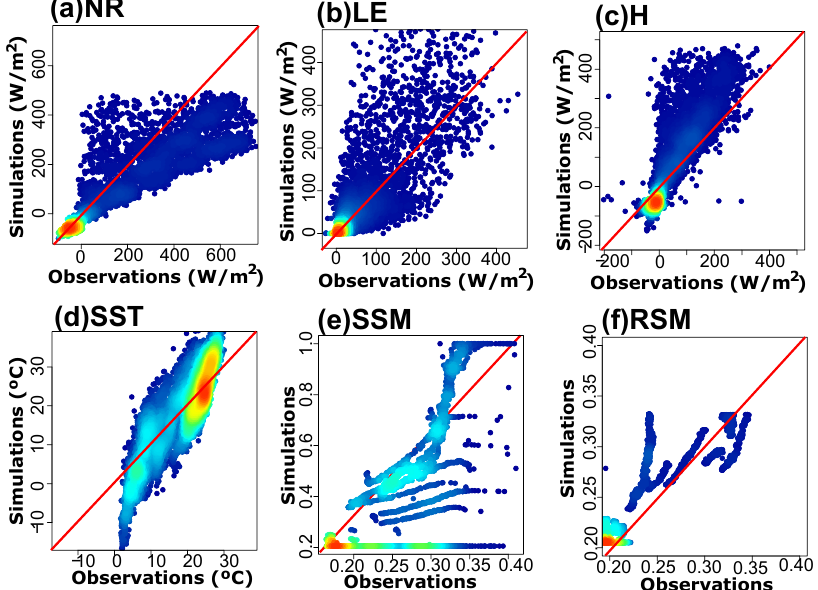
Figure 6. Density scatter plots of the calibration results at MOISST. From top-left to bottom-right: net radiation (NR, W/m 2 ), latent heat flux (LE, W/m 2 ), sensible heat flux (H, W/m 2 ), ground heat flux (G, W/m 2 ), soil surface temperature (SST, ◦ C), surface soil moisture (SSM, -), and root-zone soil moisture (RSM, -). In all panels, the x-axis represents the observed and the y-axis represents the simulated